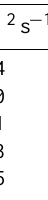
Table 2. Kinematic viscosity ( ν w ) of sea water at different sea wa- ter temperatures ( T w ). Data were interpolated for water salinity of 35gkg − 1 with parameterization by Sharqawy et al.